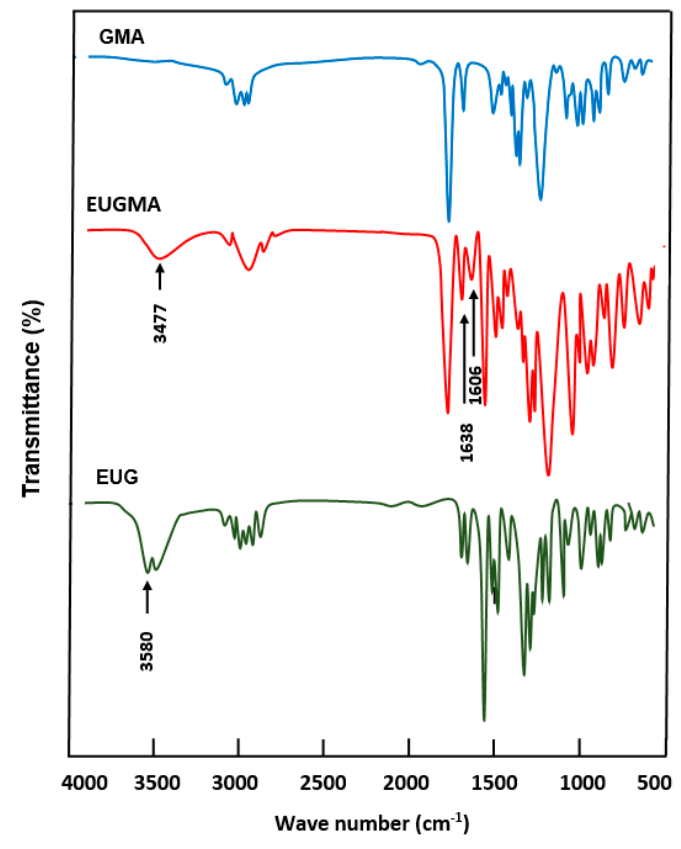
Figure 1. Fourier-transform infrared spectroscopy (FTIR) spectra of GMA, EUG and EUGMA.